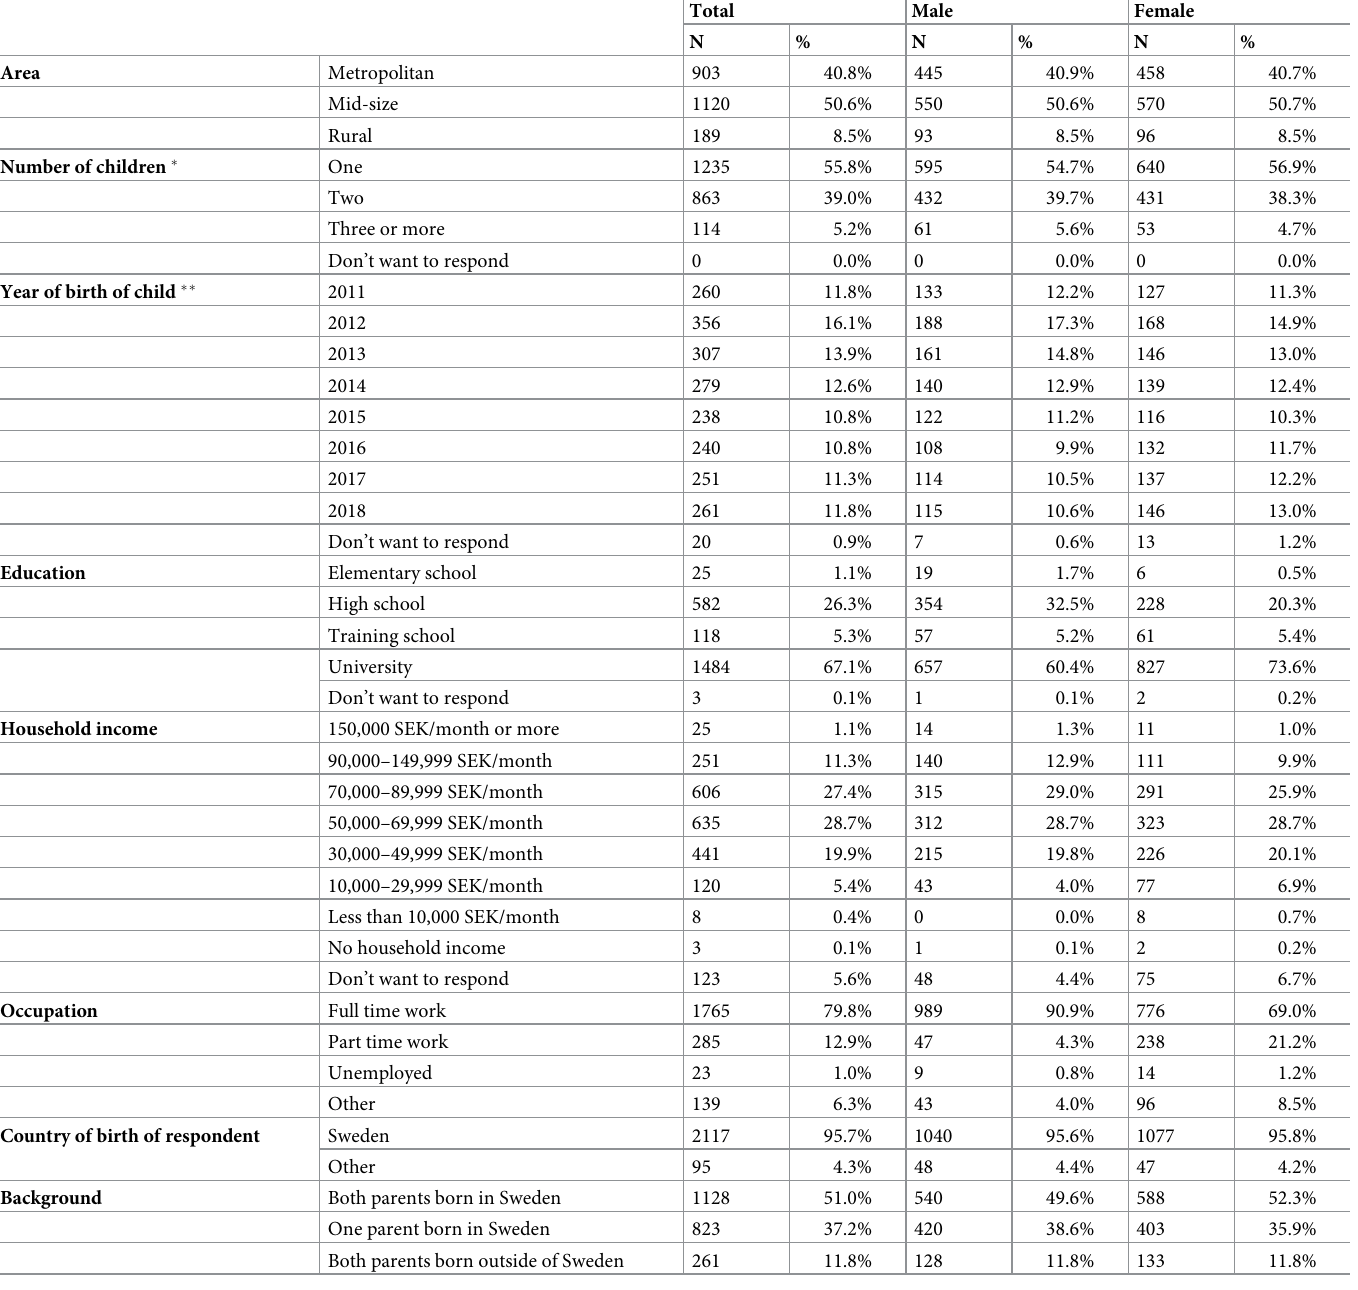
Table 2. Demographics of respondents (n =